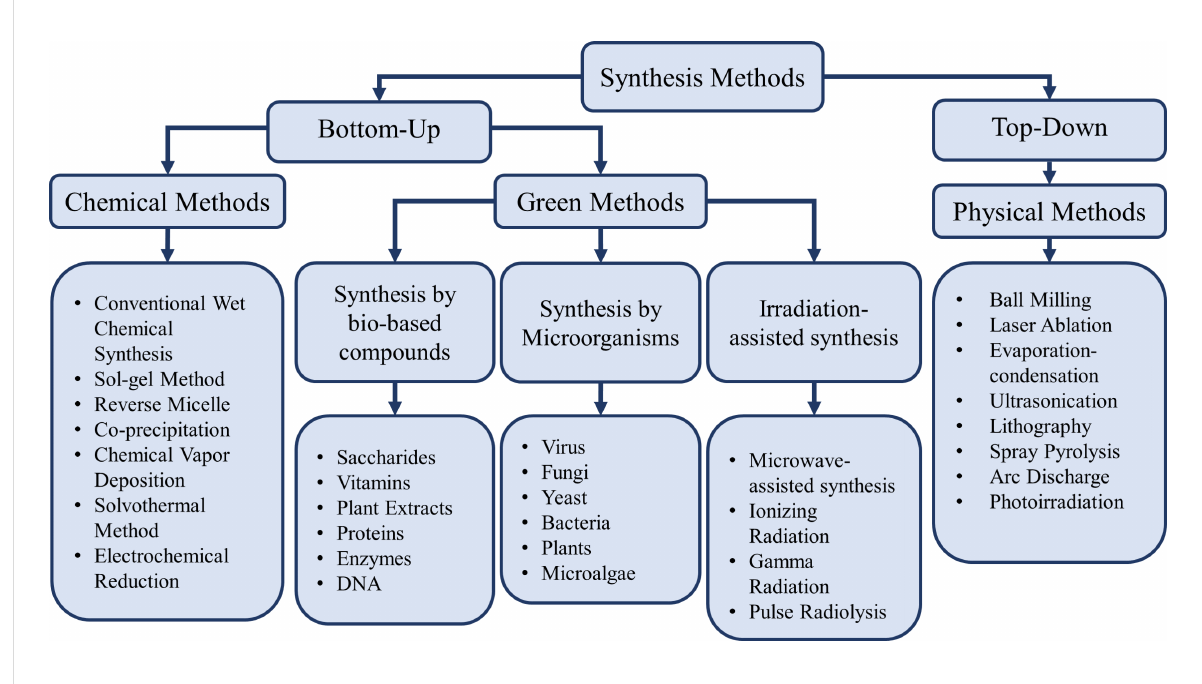
Figure 1: Classification of physical, chemical, and green synthesis methodologies of silver nanostructures with respect to reducing agent type, instru- ments, and processes.